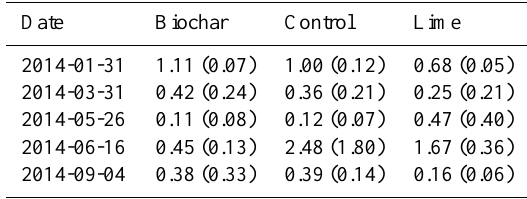
Table 2. Ammonium content (mgNH experiment. Standard error is indicated in